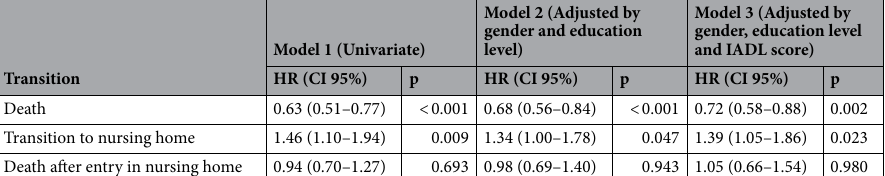
Table 5. Estimated effects of the move into senior housing on the risks of mortality and nursing home admission, illness-death model. PAQUID cohort (n = 3710).